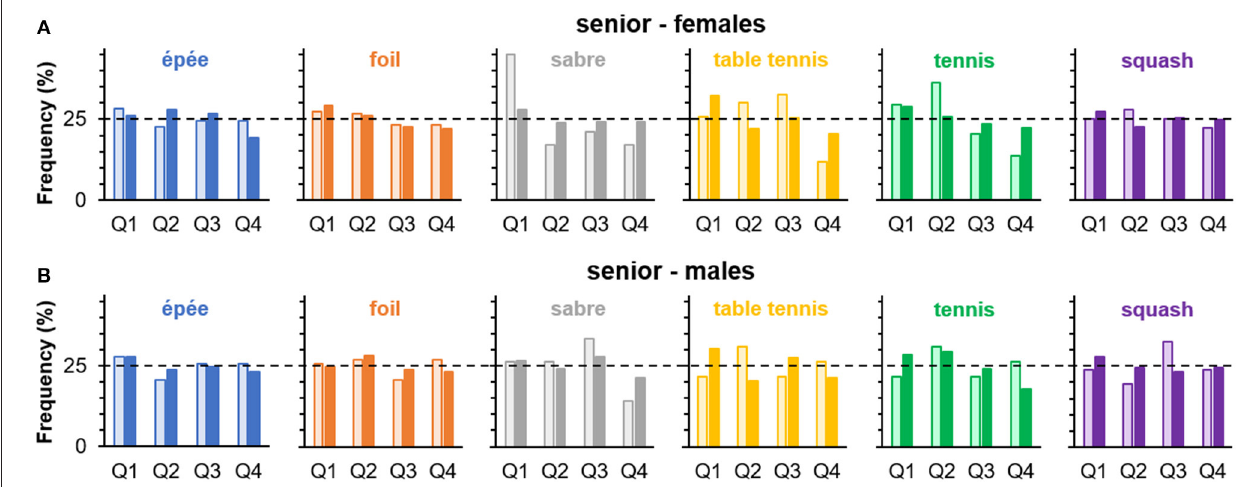
FIGURE 2 | Percentages of birth quartile (Q1–Q4) frequencies in left- ( (cid:3) ) and right-handers ( (cid:4) ) separately for sport or discipline in (A) female and (B) male senior athletes (study 1). Horizontal dashed lines indicate expected frequencies under the assumption of a uniform distribution.